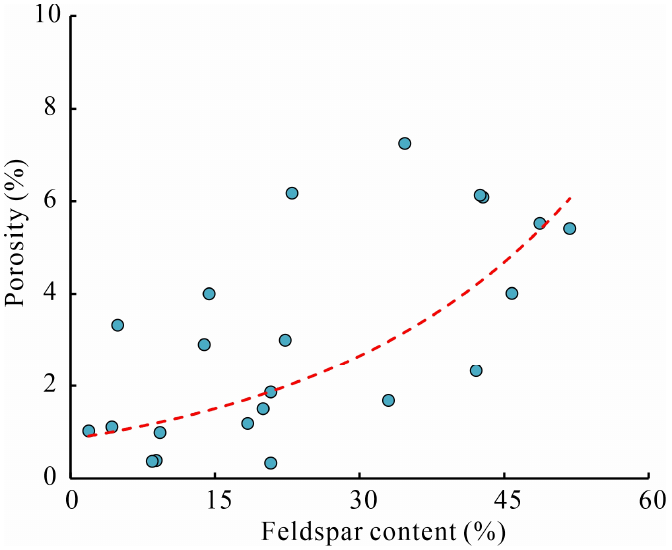
Figure 12. Diagram of the relationship between feldspar content and porosity.